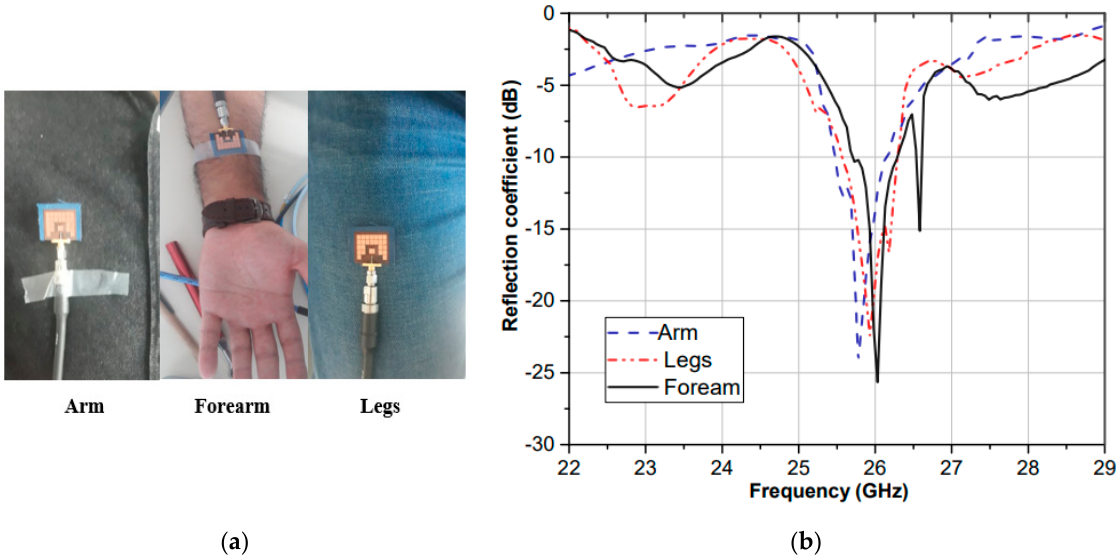
Figure 12. Antenna measured on the body: ( a ) performance evaluation of the antenna at the arm, forearm, and legs; ( b ) measured return loss S 11